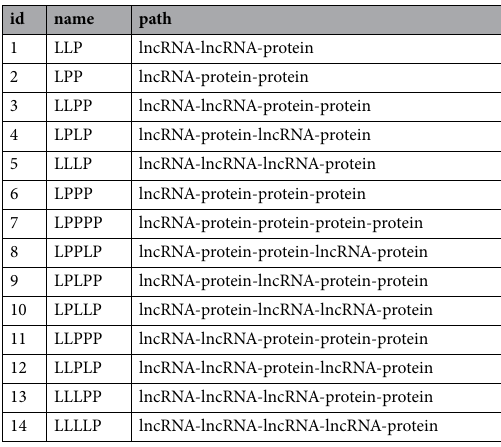
Table 1. The paths from a lncRNA to a protein in our heterogeneous network with length less than